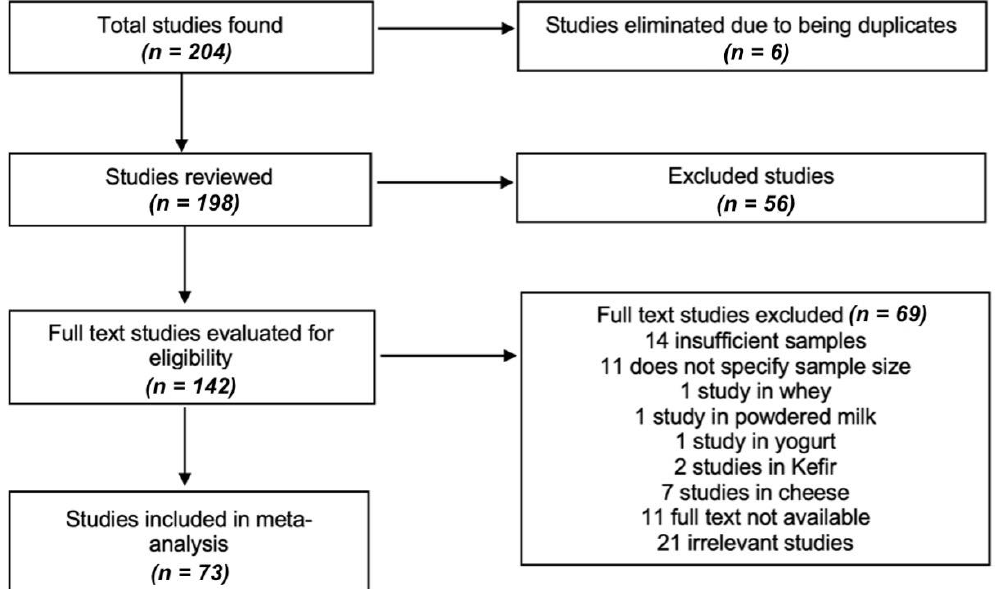
Figure 1. Flow chart summarizing the process of study